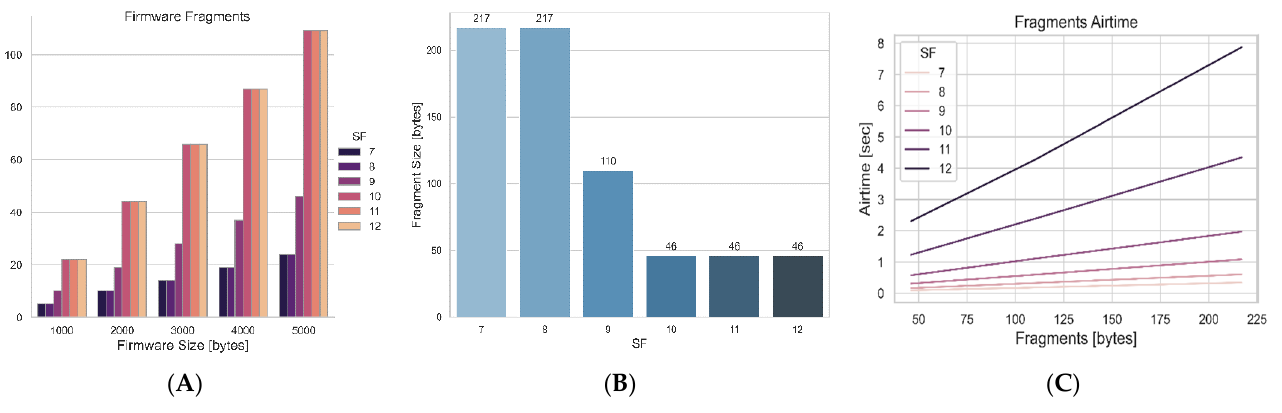
Figure 19. ( A ) Firmware Size and Number of Fragments; ( B ) Maximum Firmware Fragment Payload; and ( C ) SF and Airtime.